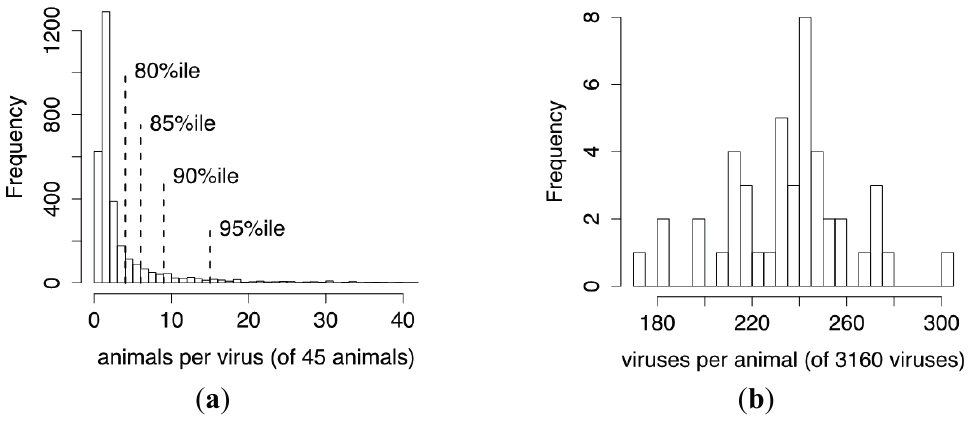
Figure 6. CrERV prevalence among animals and the number of CrERV integrations sites